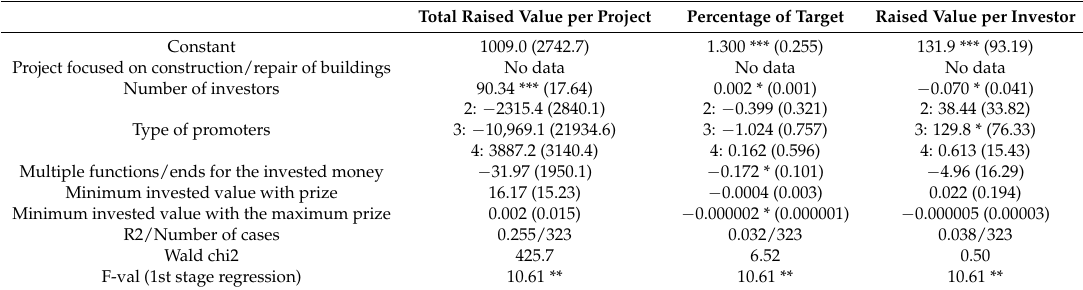
Table 5. Type of Project: Cultural/Creative Projects. Estimations for total funded value, percentage of target, and value per investor (2013–2017).